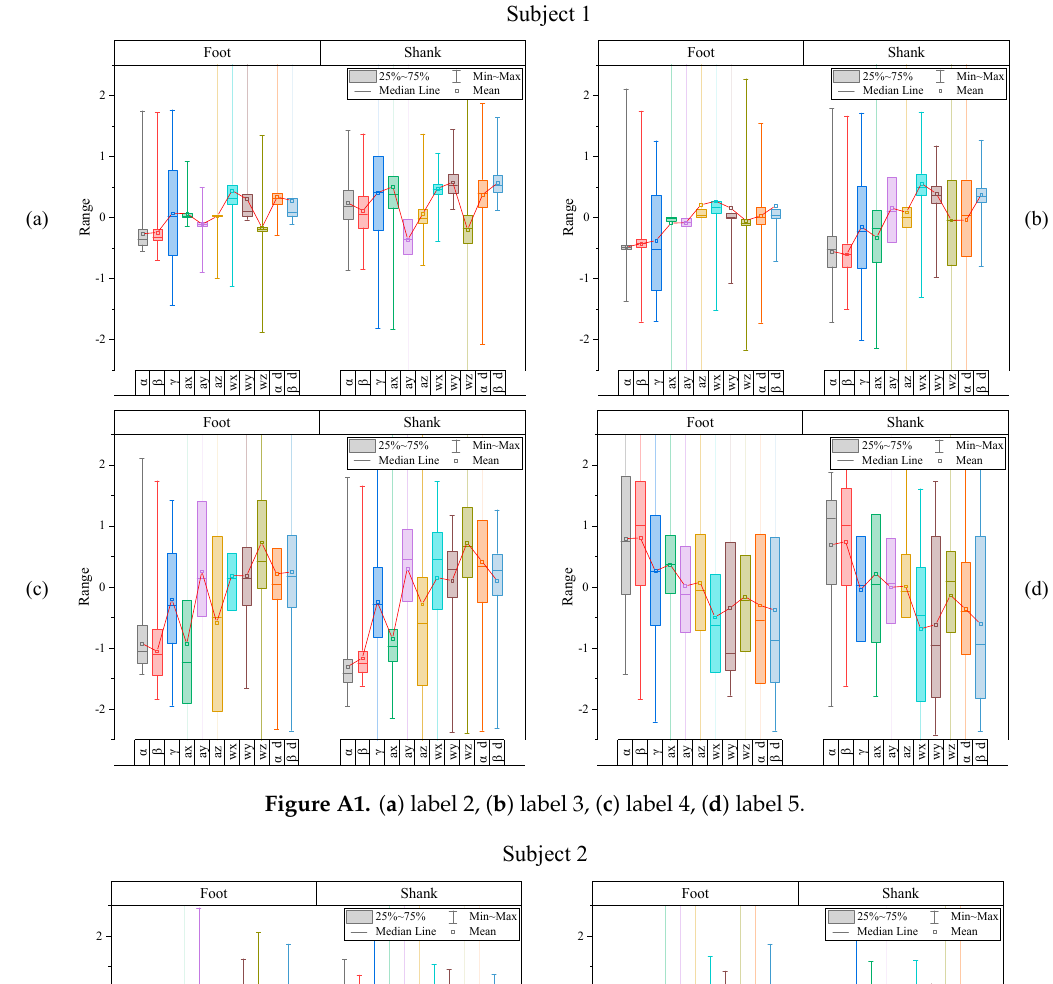
Figure A1. ( a ) label 2, ( b ) label 3, ( c ) label 4, ( d ) label 5.